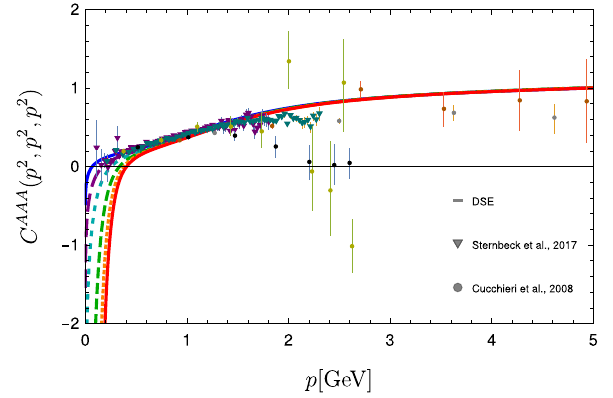
Fig. 5 Solutions for the three-gluon vertex dressing function at the symmetric point in comparison to lattice data [54,55]). For the sake of comparison, all data were renormalized to 1 at 5GeV. Different lines correspond to different decoupling/scaling solutions as explained in the